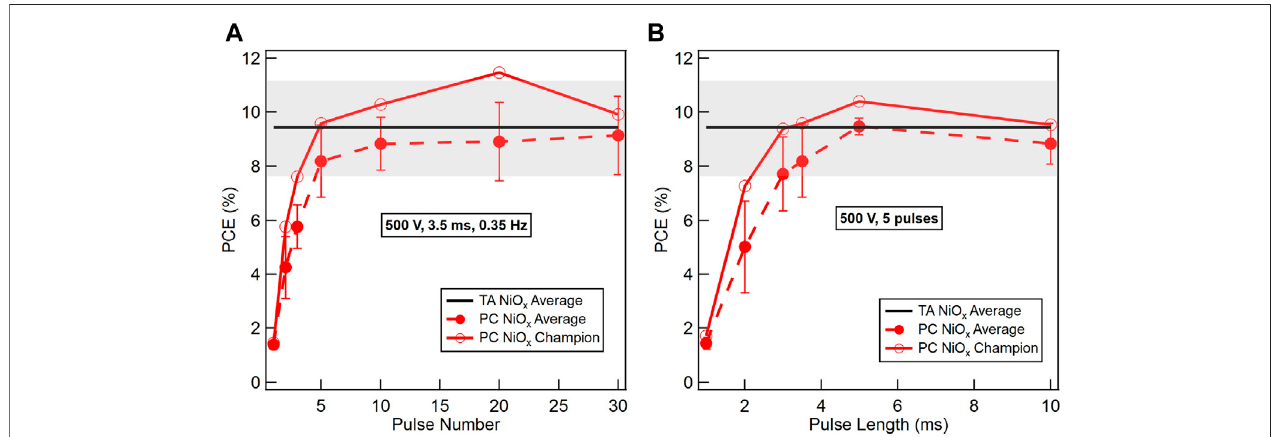
FIGURE 4 | Reverse-scan PCE of PSCs on WG/ITO fabricated by different methods. Two parameters are varied in the PC conditions: (A) The number of pulses at fi xed pulseconditionsof500 Vlampvoltage,3.5 mspulselength,and0.35 Hzrepetitionrate. (B) Thepulselengthat fi xedpulseconditionsof500 Vlampvoltageand fi vepulses.All